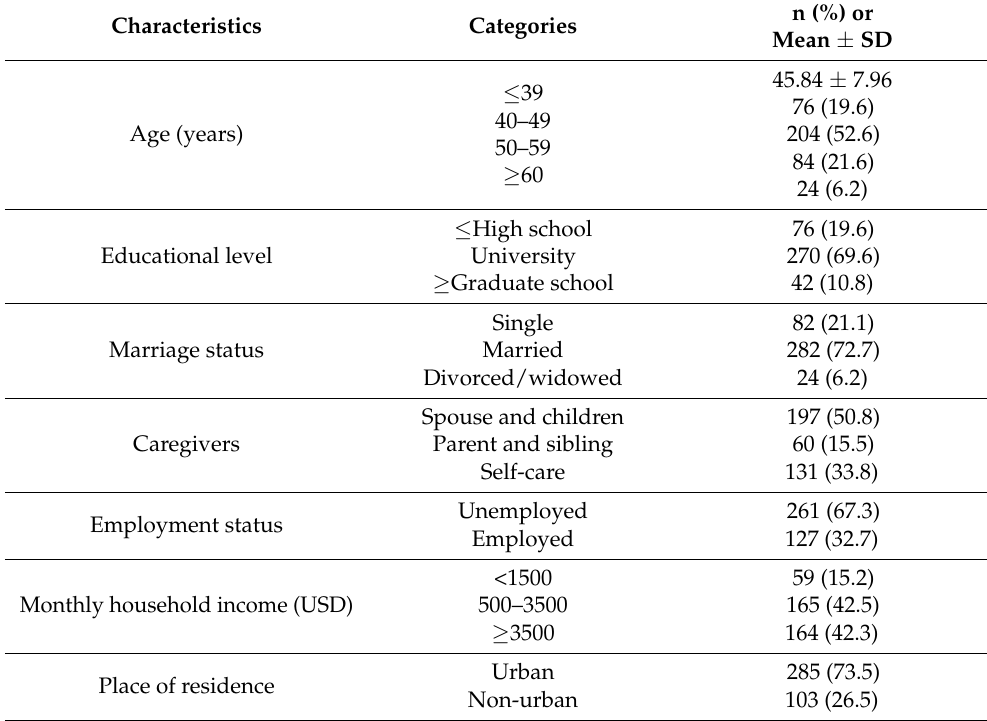
Table 1. Demographic characteristics (N = 388).